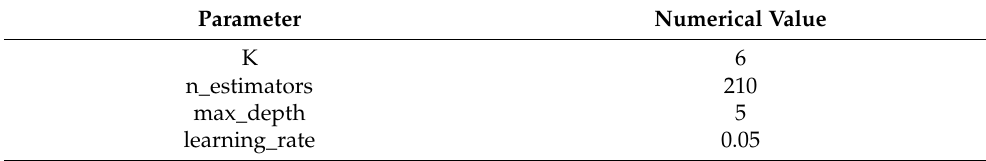
Table 4. Optimal